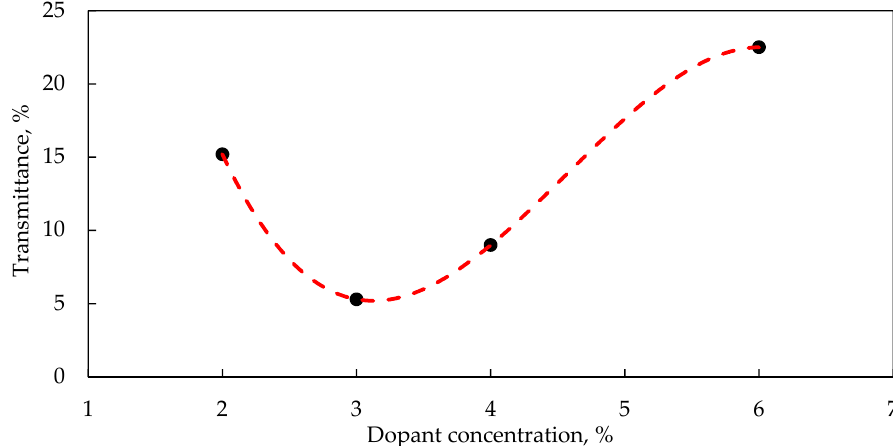
Figure 6. Change in direct optical light transmission of a PFLC light diffuser element in relation to dopant concentration. Utilized light source: white LED.